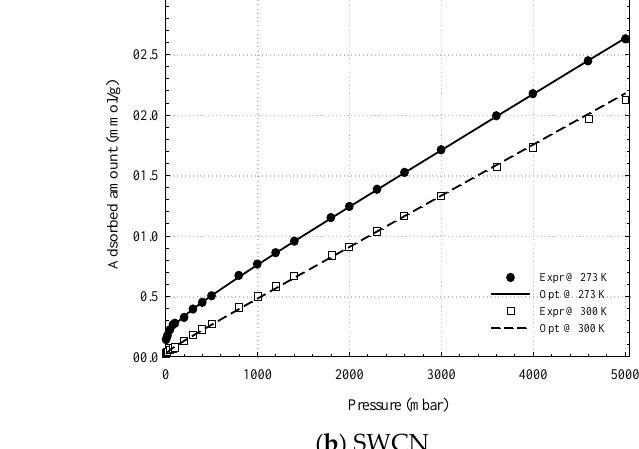
Figure 19. Comparison between the experimental data and reconstructed adsorption isotherms obtained from PSD determination for LAC1 ( a ) and SWCN ( b ) using the adsorption isotherms of CH 4 ( b ) at 273 and 300 K.